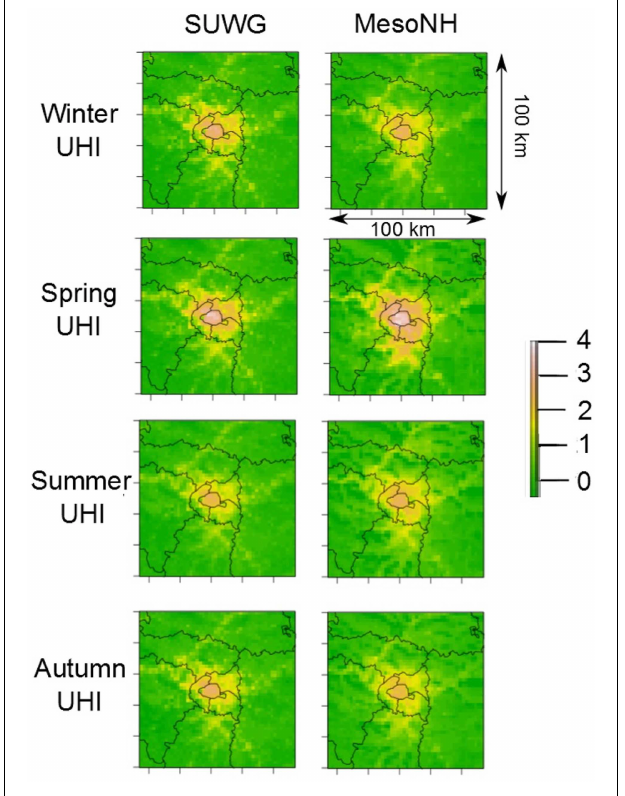
FIGURE 8 | Comparison by season of the UHI at 2m computed by the SUWG forced with an average of data files from four different airports around Paris and a full atmospheric model MesoNH simulation. TABLE 2 | Statistical evaluation of the predicted urban heat island at 2m in Paris wit with the SUWG in comparison with a reference simulation MesoNH with the MEAN simulation for each season.